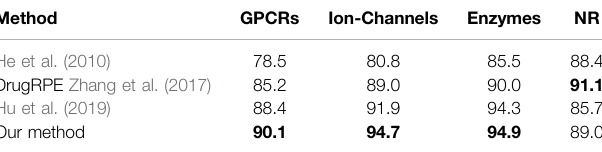
TABLE 2 | Performance comparison on four datasets inaccuracy rate. Method